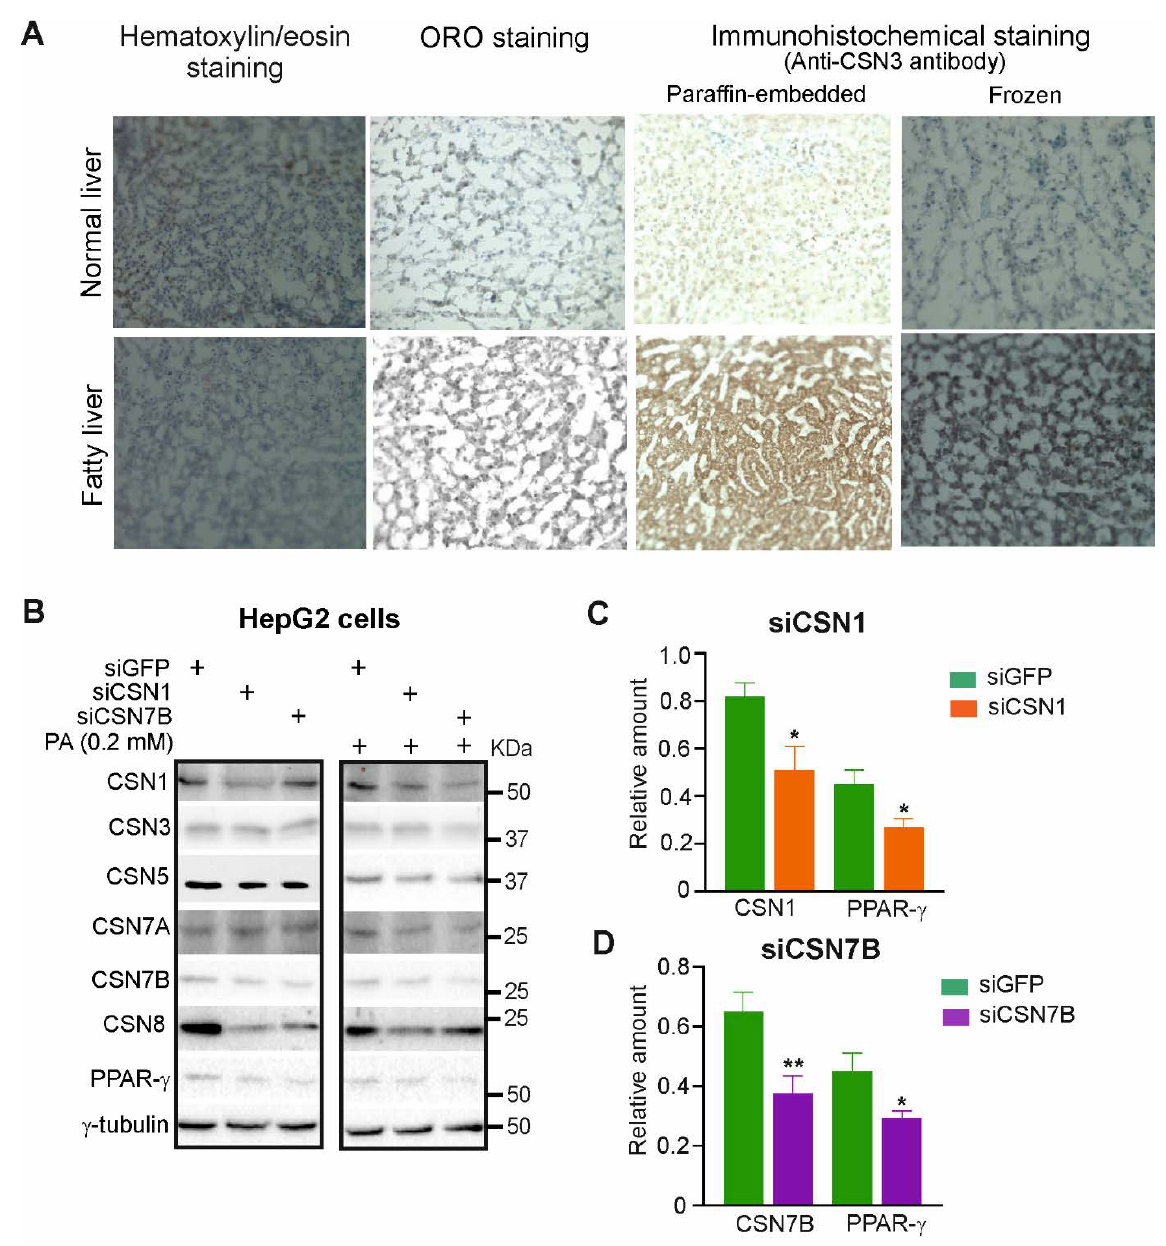
Figure 1. Silencing of CSN1 or CSN7B reduces the expression of PPAR- γ , a regulator of hepatic steatosis. ( A ) Immuno- histochemical staining using anti-CSN3 antibody in human normal and fatty liver tissue. Hematoxylin/eosin staining visualized nuclei, whereas ORO staining shows the number of LDs. Staining was visualized by light microscopy at 200-fold magnification. ( B ) Levels of the indicated proteins were assessed by Western blot analysis of HepG2 cells without (left panel) or with treatment using 0.2 mM PA (right panel) For 24 h. Control siRNA (siGFP) or siRNA directed against CSN1 (siCSN1) or CSN7B (siCSN7B) was transiently transfected into HepG2 cells 24 h before treatment with PA. ( C , D ) Blots as shown in ( B ) (left panel) were quantified by densitometry to measure the abundance of CSN1, CSN7B and PPAR- γ after transfection with siCSN1 ( C ) or siCSN7B ( D ). Data were normalized to γ -tubulin and are expressed as means of relative amounts plus/minus standard deviations (SD, n = 3). Unpaired Student’s t -test was used for statistical analysis. * p < 0.05, ** p < 0.01.